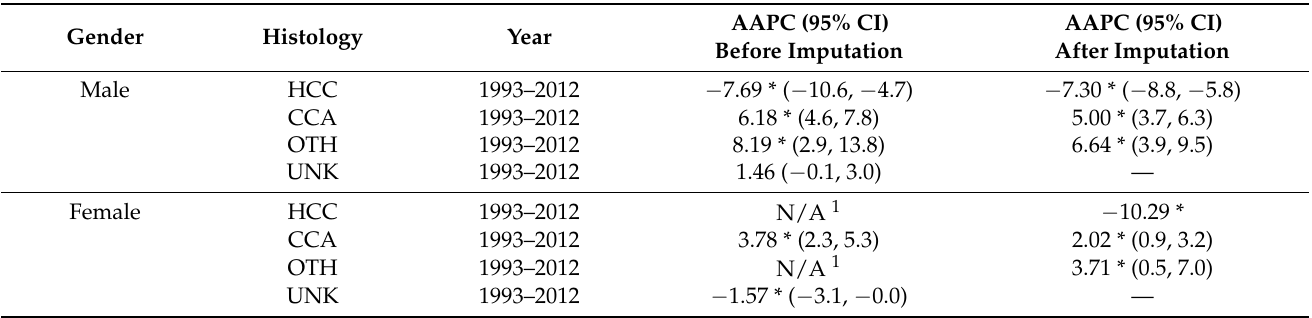
Figure 1. Age-adjusted incidence rate trends by sex and histology before and after imputation. Table 2. Average Annual Percent Change (AAPC) by sex and histology before and after imputation.